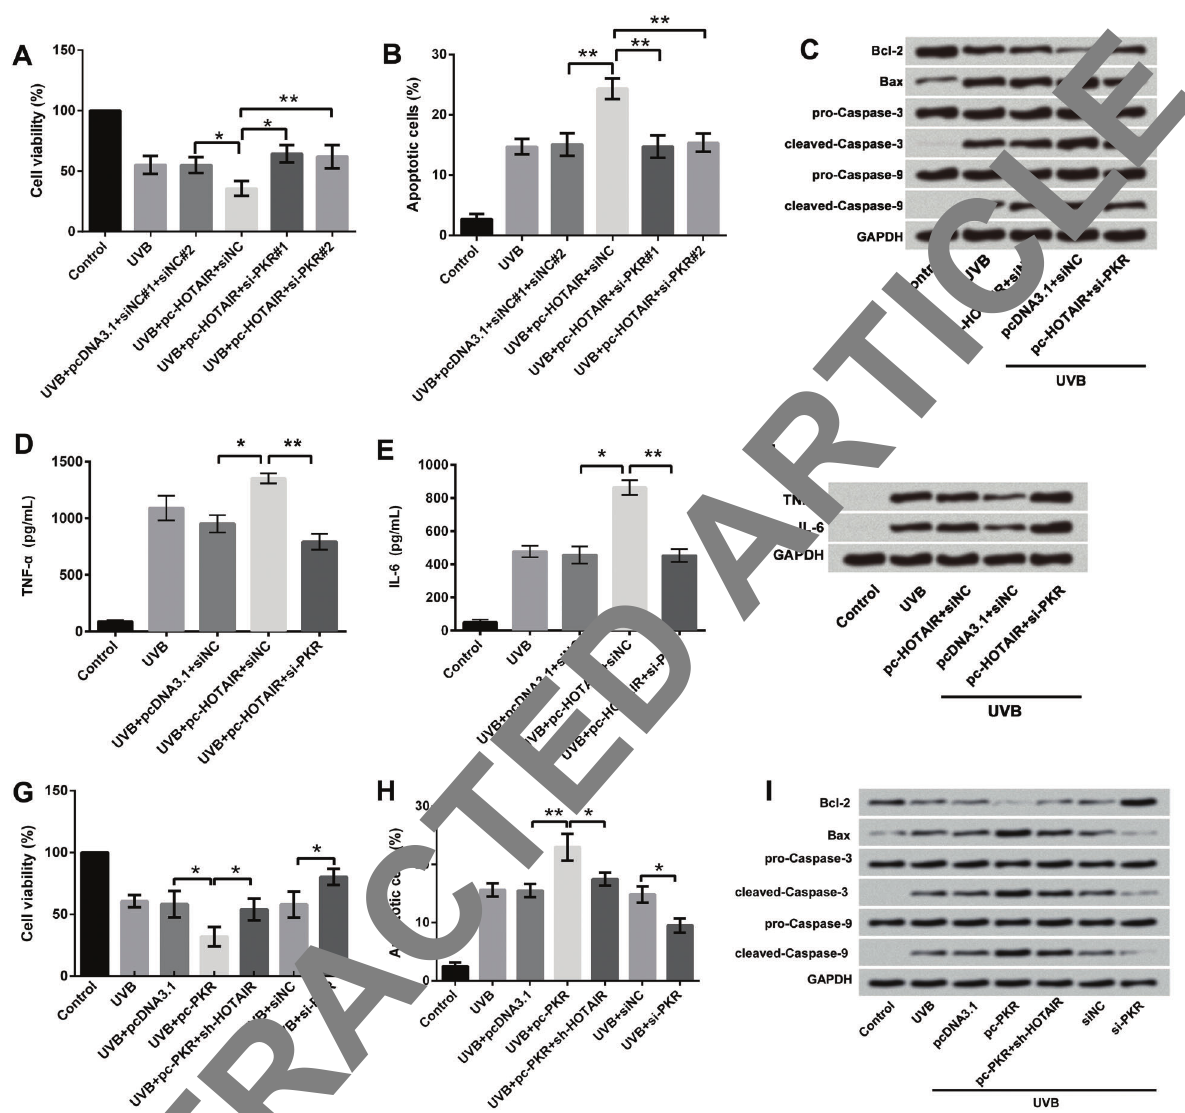
Figure 6. Effect of HOTAIR and PKR on UVB-induced cell injury; A , Cell viability assay demonstrated overexpression of HOTAIR promoted UVB-induced cell viability inhibition by upregulation of PKR, and suppression of PKR reversed the results; B, Apoptosis assay showed overexpression of HOTAIR promoted UVB-induced cell apoptosis by upregulation of PKR, and suppression of PKR reversed the results; C, Western blotting analysis revealed overexpression of HOTAIR promoted the effects of UVB on apoptosis-related factors by upregulation of PKR, and suppression of PKR reversed the results; D and E , ELISA revealed overexpression of HOTAIR promoted UVB-induced high expression of TNF- a and IL-6 by upregulation of PKR, and suppression of PKR reversed the results; F , Western blotting analysis showed overexpression of HOTAIR promoted UVB-induced high expression of TNF- a and IL-6 by upregulation of PKR, and suppression of PKR reversed the results; G , Inhibiting expression of HOTAIR reversed the viability-inhibitory effect of PKR; H , Inhibiting expression of HOTAIR reversed the apoptosis-promoting effect of PKR; I , HOTAIR silence reversed the effects of PKR on apoptosis-related factors. Data are reported as means ± SD. *P o 0.05; **P o 0.01 (ANOVA). UVB treatment time was 16 h. HOTAIR: HOX antisense intergenic RNA; PKR: RNA-dependent protein kinase; UVB: ultraviolet B; qRT-PCR: quantitative real-time polymerase chain reaction; TNF- a : tumor necrosis factor- a ; IL-6: